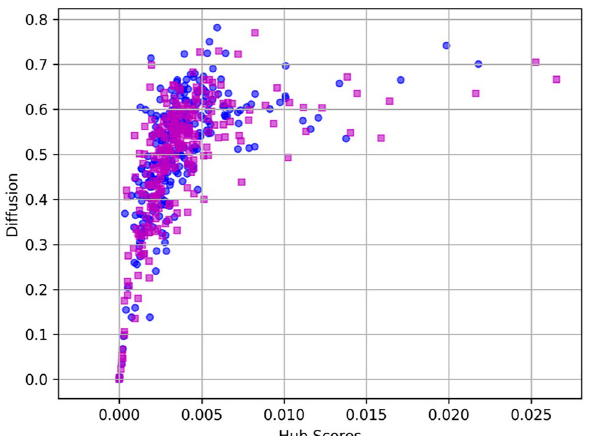
Fig. 4 Association between hub score centralities and diffusion. Blue circles are data for 2008, and magenta squares for 2012. Spearman correlation coefficient. r 0.714, p value 0.000 for 2008, and Spearman = = correlation coefficient r 0.722, p value 0.000 in 2012. This figure was generated by authors based on INEGI = = data using Python 3.8 and Python libraries scipy, numpy, and matplotlib. Source: Visualizations made by